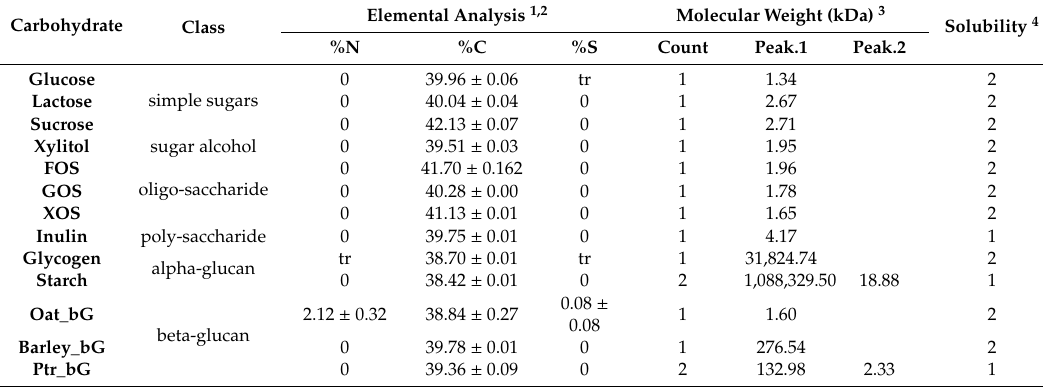
Table 1. Purity, molecular weights, and solubility assessment of the 13 carbohydrates. Purity was accessed by elemental analysis; pure carbohydrate should consist only C, H and O. The presence of N and S indicated the presence of protein. Molecular weight was determined by size exclusion chromatography (SEC) with calibration by external dextran